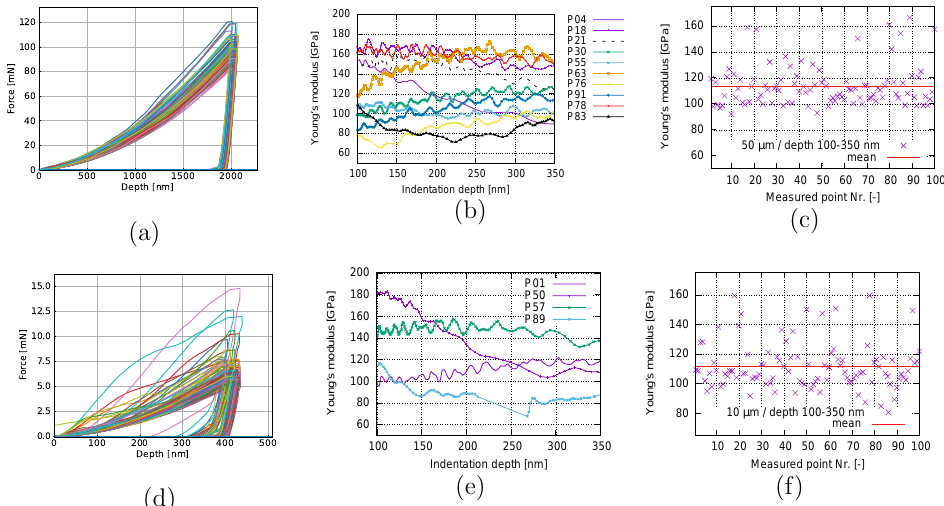
Fig. 4: Applied force and Young’s modulus v.s. penetration depth and the recalculated mean values of Young’s moduli from the nanoindentation test (HV0.3) for PM 12-2 MMC in the longitudinal section: (a)-(c) and Fig. 3 (a) from the same test; (d)-(f) according to Fig. 3 (b).